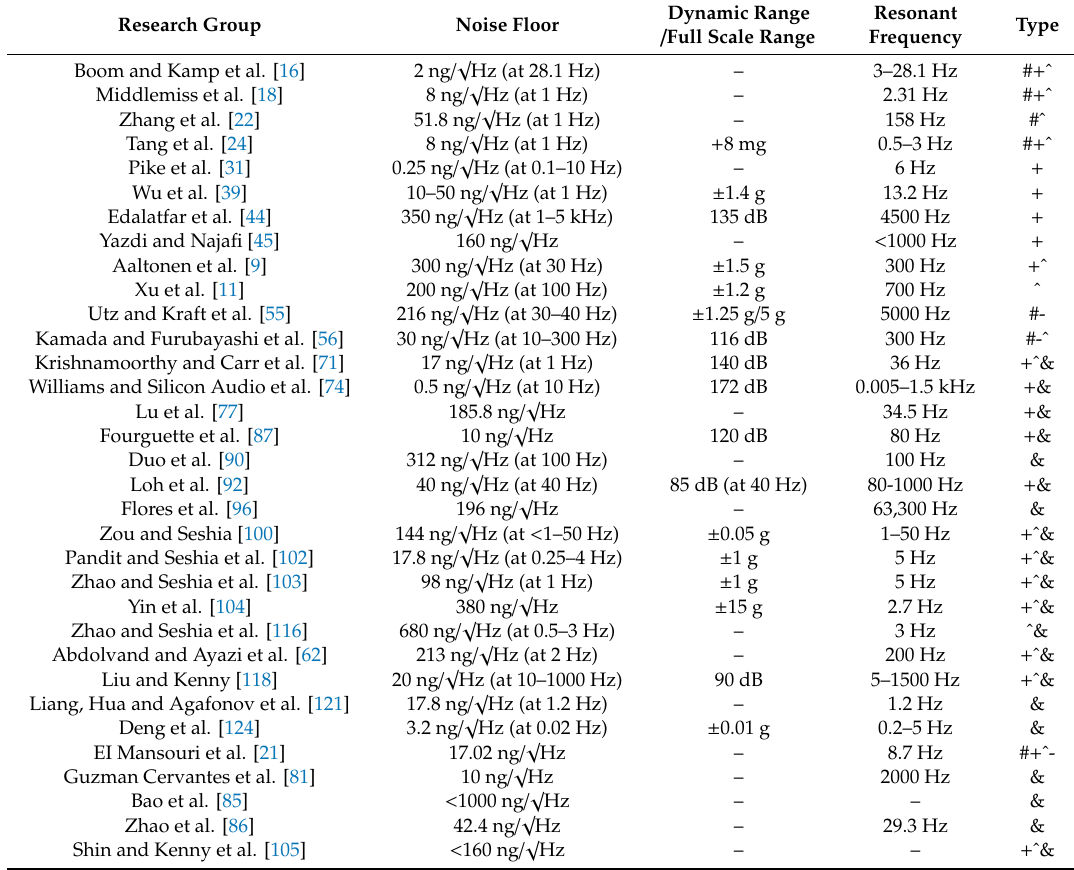
Figure 24. Comparison of micromachined accelerometers with a sub-µg/ √ Hz noise floor. “+” refers to large proof mass, “#” refers to low spring constant, “–“ refers to low noise interface circuit and “^” refers to high Q. Table 3. Summary of micromachined accelerometers with a sub-µg/ √ Hz noise floor.